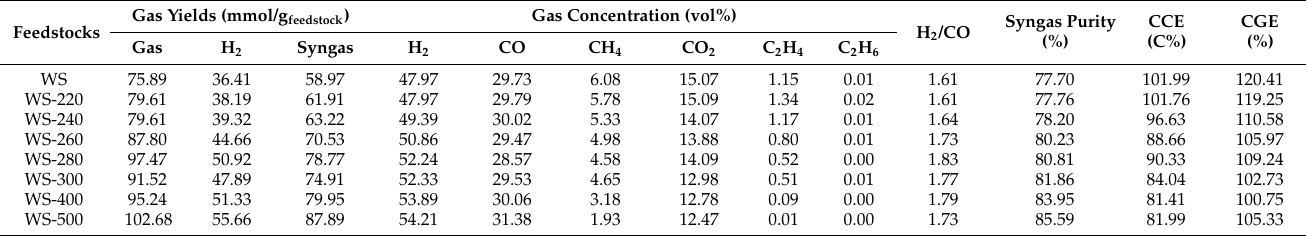
Table 2. Gas formation behaviors from steam gasification of torrefied/carbonization wheat straw at 900 °C.